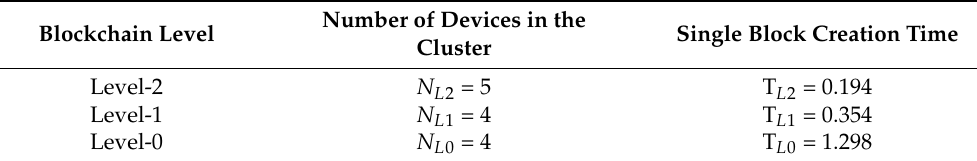
Table 5. Blockchain levels and their respective number of devices in each cluster and the single block creation